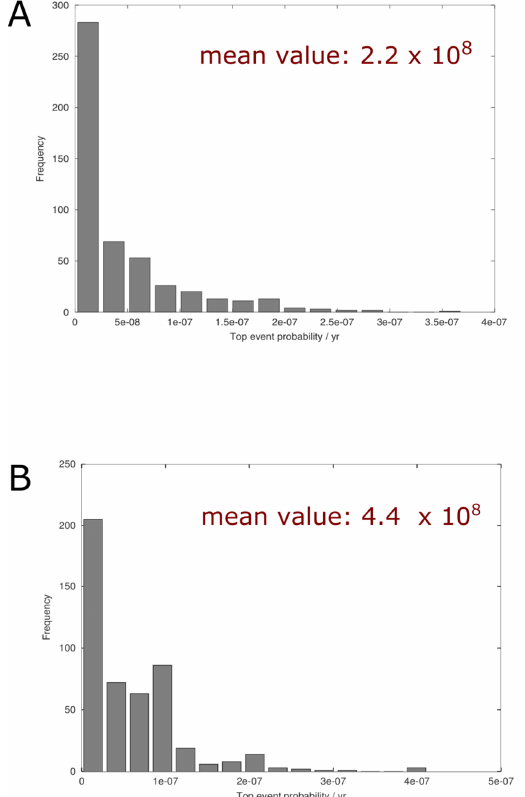
Figure 15. ( A ) Histograms for the probability of a diesel spill during the site construction and drilling phase. Corresponding to Fault Three 1. Median 2.2 × 10 − 8 ; ( B ) Histograms for the probability of a diesel spill due to material fatigue during the construction and drilling phase, corresponding to Fault Three 2. Median 4.4 × 10 − 8 .